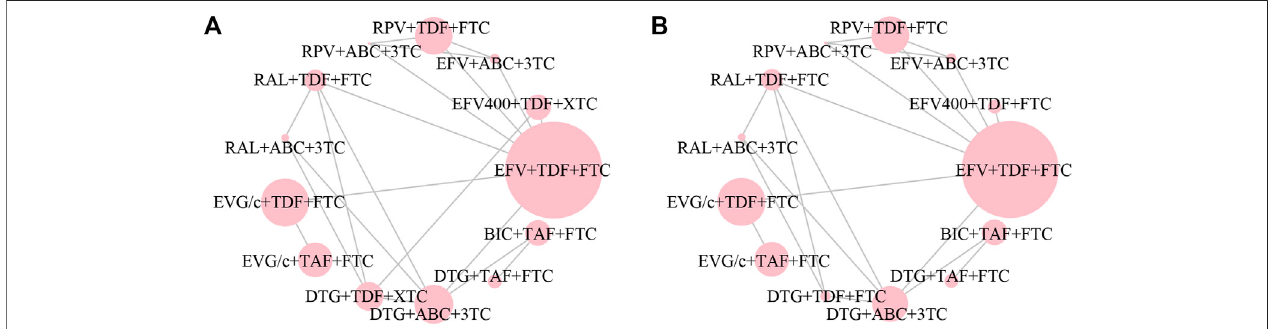
FIGURE 3 | Network plot of treatment comparisons for the outcome of virologic suppression (A) at 48 weeks and (B) at 96 weeks. The larger the circle, the more participants included. ABC, abacavir; BIC, bictegravir; DTG, dolutegravir; EFV, efavirenz; EFV400, 400 mg efavirenz; EVG/c, cobicistat-boosted elvitegravir; FTC, emtricitabine; RAL, raltegravir; RPV, rilpivirine; TAF, tenofovir alafenamide; TDF, tenofovir disoproxil fumarate; XTC, FTC/3TC; 3TC, lamivudine.